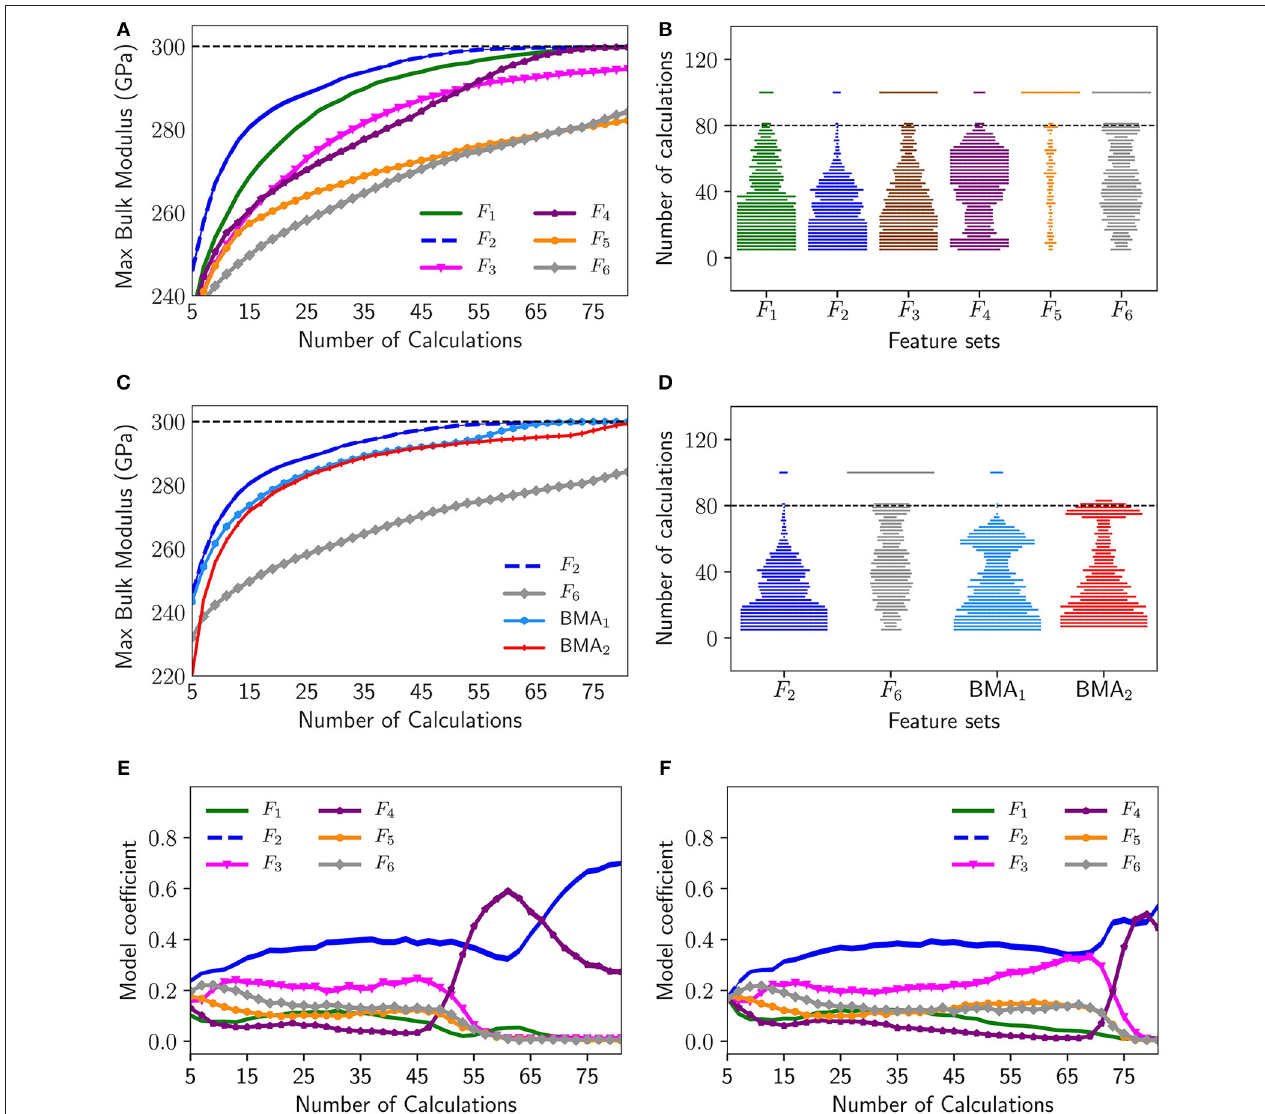
FIGURE 7 | Representative results for single objective optimization–maximization of bulk modulus for N = 5: (A) Average maximum bulk modulus discovered using all described feature sets, (B) swarm plots indicating the distribution of the number of calculations required for convergence using all described feature sets, (C) average maximum bulk modulus discovered using the best feature set F 2 , worst feature set F 6 , BMA 1 , and BMA 2 , (D) swarm plots indicating the distribution of the number of calculations required for convergence using the best feature set F 2 , worst feature set F 6 , BMA 1 , and BMA 2 , (E) Average model probabilities for maximizing bulk modulus using BMA 1 , (F) Average model probabilities for maximizing bulk modulus using BMA 2 .